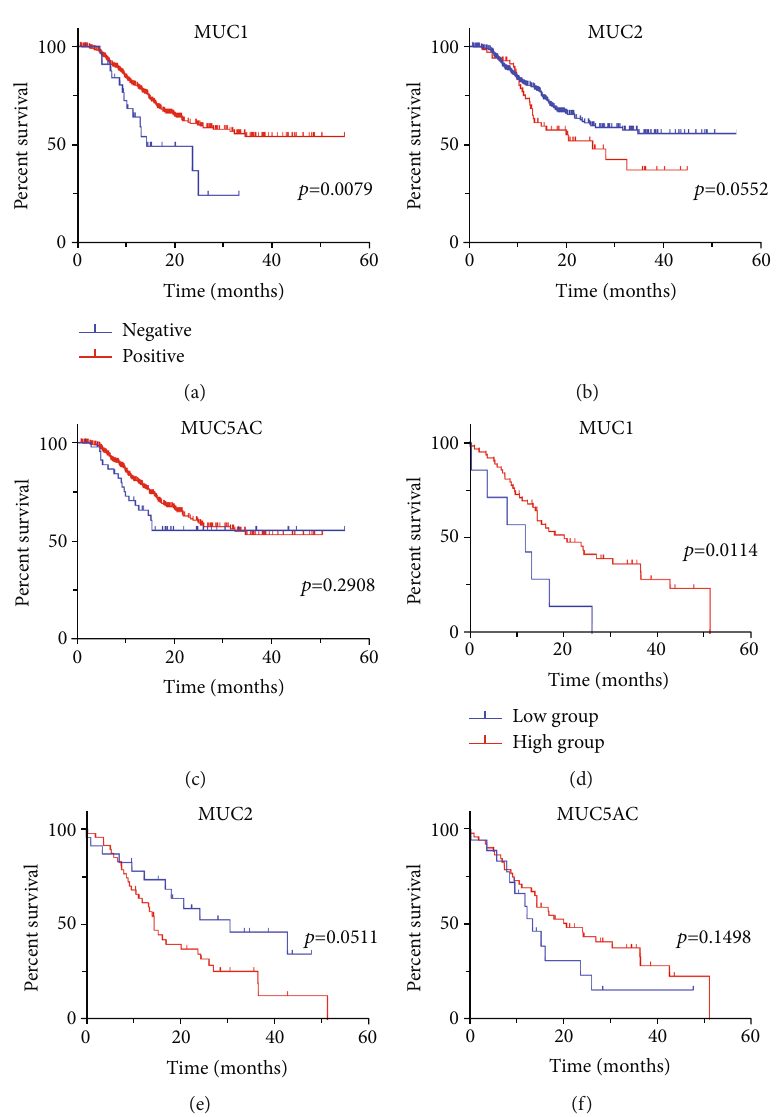
Figure 2: Survival curves of PDAC patients in relevant to mucin expression. The survival plots were plotted by Kaplan-Meier ’ s method, and Mantel-Cox tests were used to compare the curves. (a – c) FUSCC cohort was strati fi ed by mucins ’ IHC staining results. (a) MUC1-negative patients ( n = 34 ) had worse survival compared to MUC1-positive patients ( n = 392 ). (b) MUC2-positive patients ( n = 69 ) tended to survive a shorter time compared to MUC2-negative patients ( n = 355 ). (c) There was no statistical signi fi cance of overall survival between the subgroups strati fi ed by MUC5AC expression ( n = 365 and n = 47 , respectively). (d) The cut-o ff value of 77.90 TPM strati fi ed the QCMG cohort into the high MUC1 expression subgroup ( n = 63 ) and the low MUC1 expression subgroup ( n = 7 ) with a signi fi cant di ff erence in OS. (e) The cut-o ff value of 0.682 TPM strati fi ed the QCMG cohort into the high MUC2 expression subgroup ( n = 47 ) and the low MUC2 expression subgroup ( n = 23 ) with a marginally signi fi cant di ff erence in OS. (f) The cut-o ff value of 17.83 TPM strati fi ed the QCMG cohort into the high MUC5AC expression subgroup ( n = 52 ) and the low MUC5AC expression subgroup ( n = 18 ); although the survival curves had a separating tendency in the early stage, there was no statistical OS di ff erence. Abbreviations: PDAC: pancreatic ductal